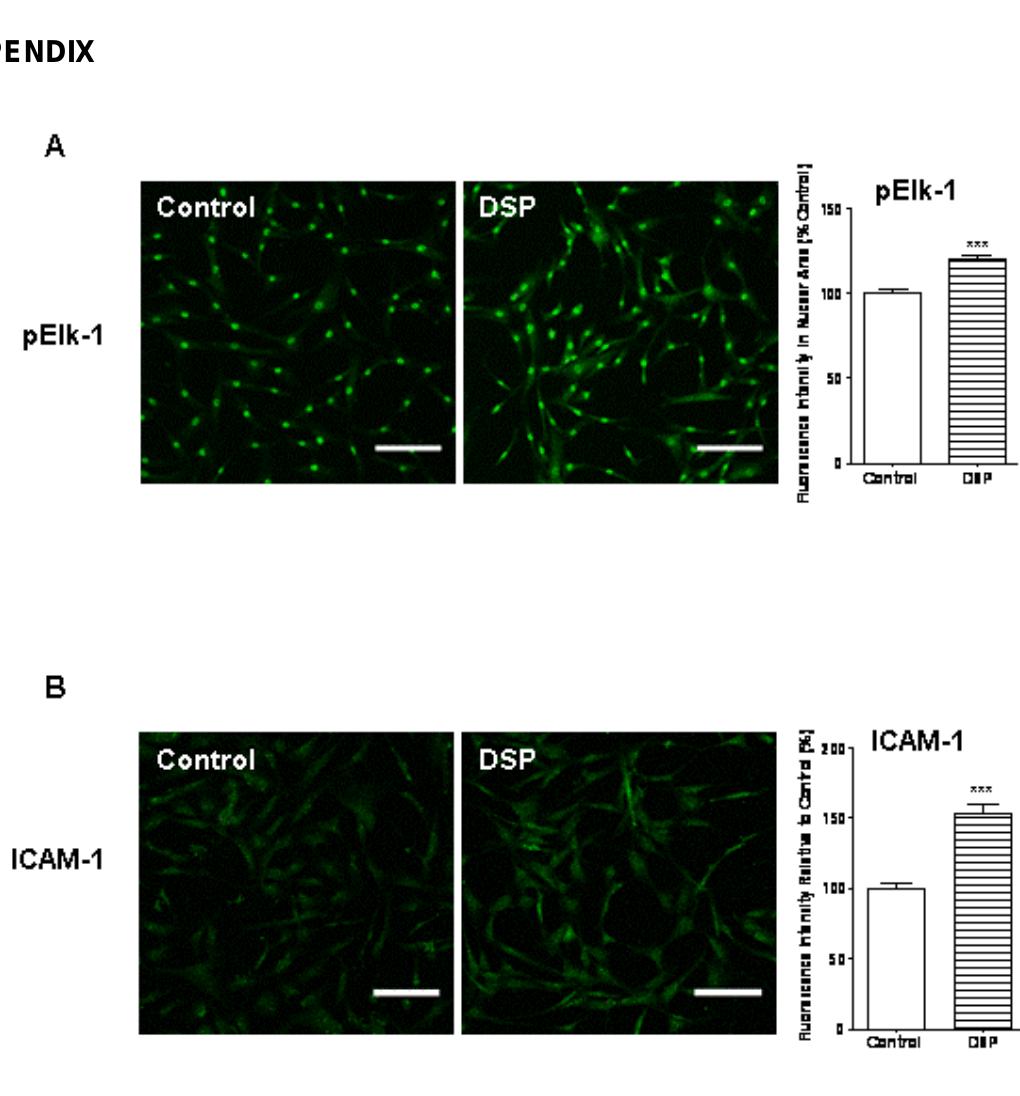
FIGURE 1. The data provided represent the immunofluorescence analysis of DSP-induced expression of ICAM-1 and phosphorylation of Elk-1. Serum-starved cells were treated with 0.2 μl/ml of DSPs for 24 h. Bar graphs show the results of statistical analysis of the fluorescence intensities for phosphorylated Elk-1 in nuclear area (A) and the expression of ICAM-1 (B). The left panels indicate representative images of immunofluorescence. The scale bar in each image represents 20 μm. Data represent mean ± S.E.M. *** p < 0.001 vs. control; p =